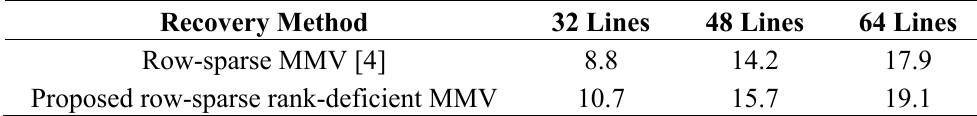
Table 2. In vivo : SNR for same Fourier mapping with all